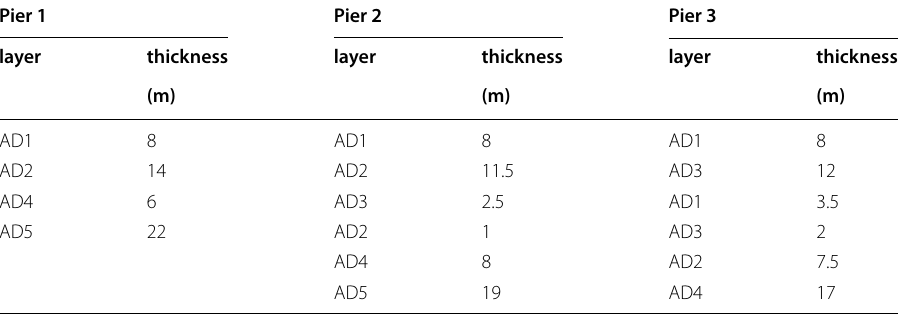
Table 2 Stratigraphy of soil profiles underneath the first, second and third pier Pier 1